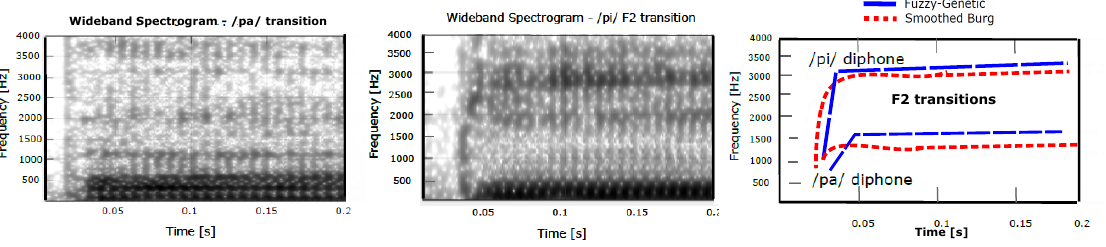
Figure 14. Second formant transitions of /pi/ /pa/ diphones.